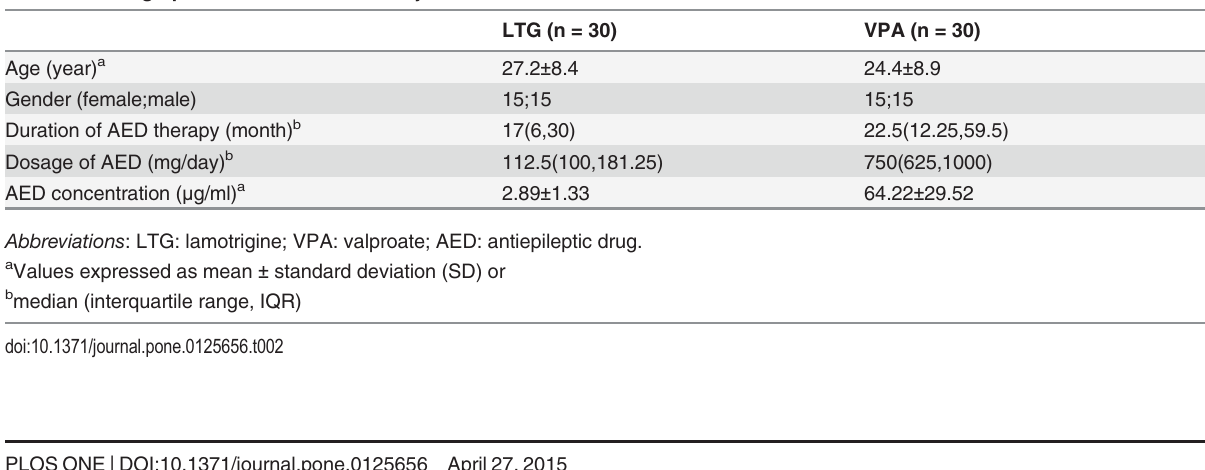
Table 2. Demographic features of all the